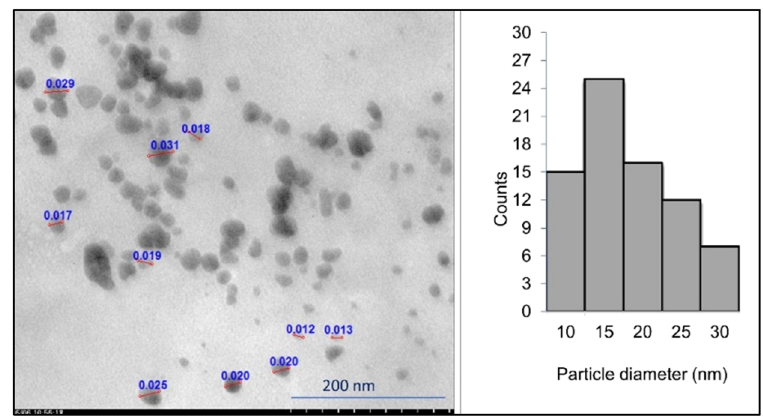
Figure 4: TEM image of AgNPs@Org and particle size